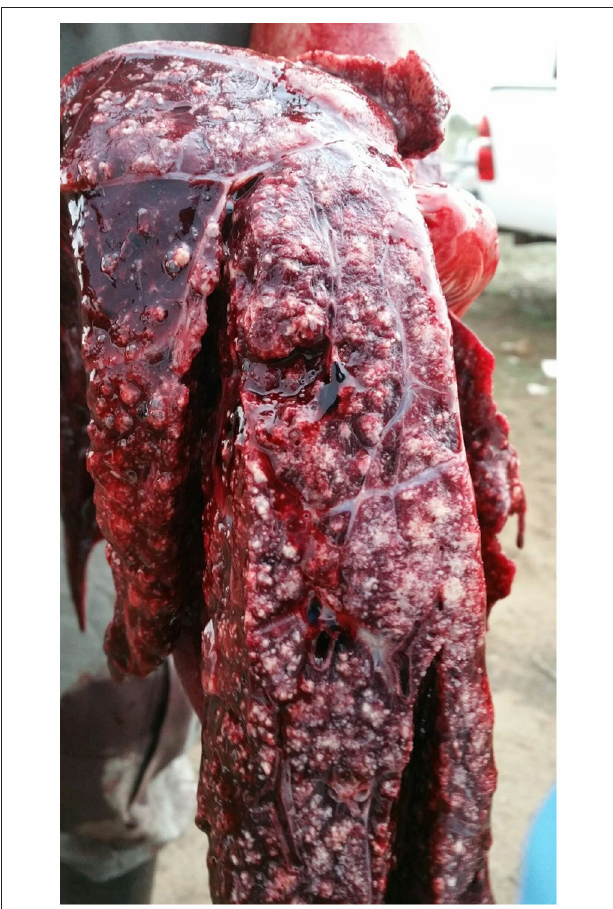
FIGURE 2 | Image of gross pathological changes in lungs of African elephant with Mtb disease. Lung lesions comprised a mixture of cavitating lesions and military focal granulomas.